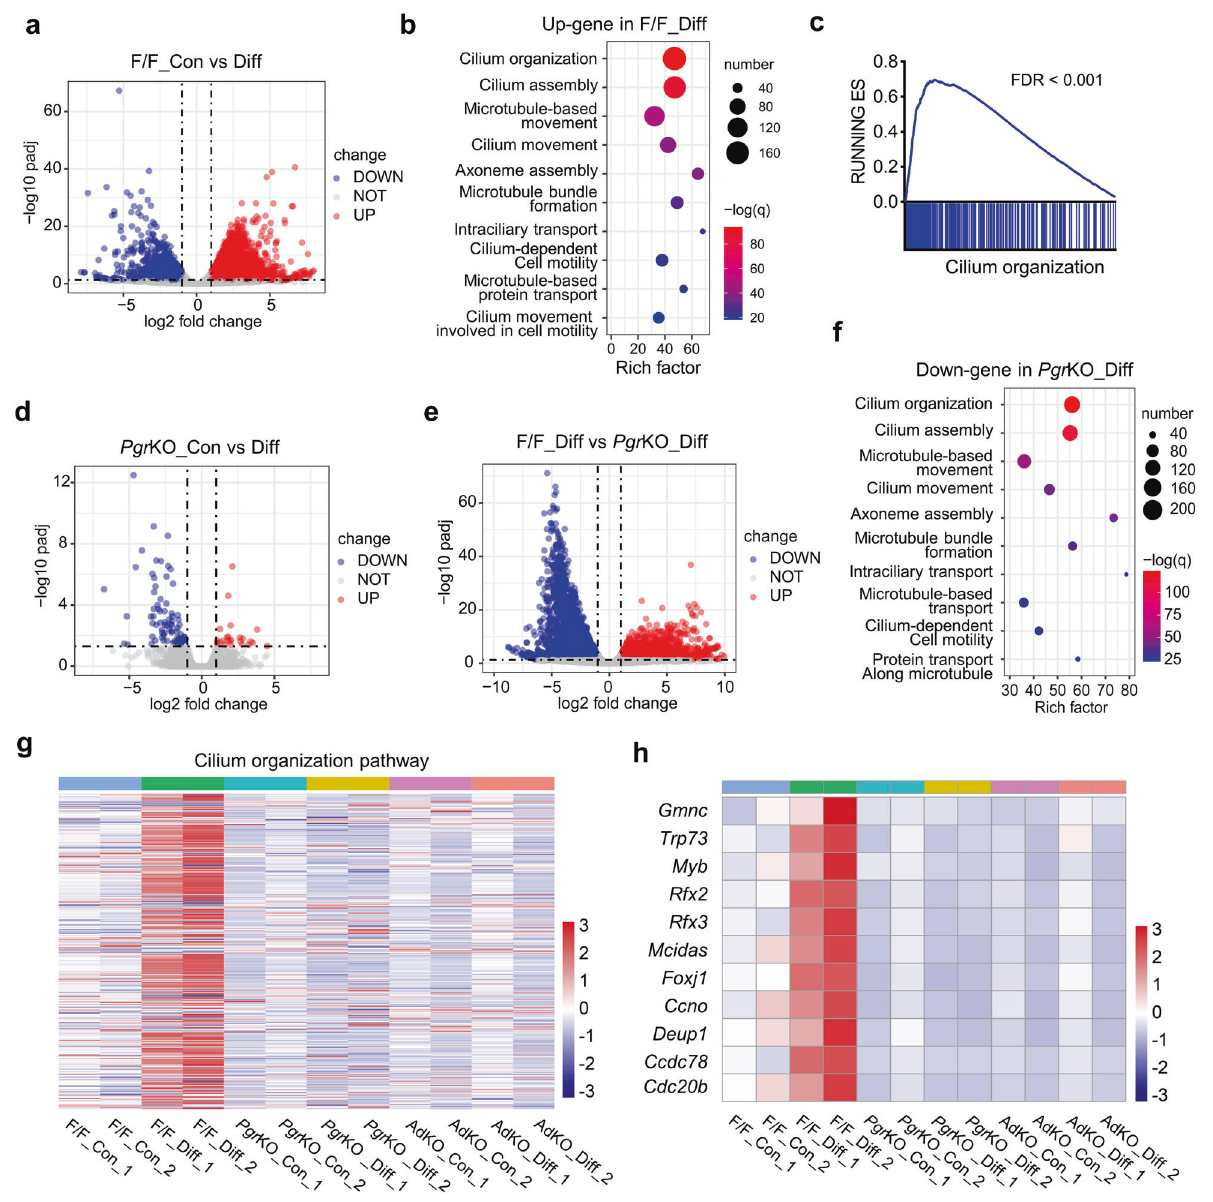
Fig. 5 CDC42 de fi cient oviductal organoids failed respond to the differentiation induction signal. a Volcano plot of differentially expressed genes in differentiated Cdc42 f/f (F/F) organoids (F/F_Diff) compared with undifferentiated F/F organoids (F/F_Con). b Go enrichment analysis of up-regulated genes in the F/F_Diff organoids compared with F/F_Con organoids. c The “ Cilium organization ” gene set was enriched in F/ F_Diff organoids according to GSEA. d Volcano plot of differentially expressed genes in differentiated Pgr KO organoids ( Pgr KO_Diff) compared with Pgr KO_Con organoids. e Volcano plot of differentially expressed genes in Pgr KO_Diff organoids compared with F/F_Diff organoids. f Go enrichment analysis of down-regulated genes in the Pgr KO_Diff organoids compared with F/F_Diff organoids. g Heatmap based on unsupervised hierarchical clustering of cilium organization pathway (GOTerm GO:0044782) and h heatmap of indicated genes expression among undifferentiated F/F organoids (F/F_Con), differentiated F/F organoids (F/F_Diff), undifferentiated Pgr KO organoids ( Pgr KO_Con), differentiated Pgr KO organoids ( Pgr KO_Diff), undifferentiated Ad-Cre-mediated Cdc42 knockout (AdKO) organoids (AdKO_Con), and differentiated AdKO organoids (AdKO_Diff). The expression levels in the heatmaps are provided as Z-scores with a range between − 3 and 3. N = 2 for each CDC42 and phospho-AKT, and reduced number of multiciliated more in the ectopic pregnancy group than that in the control cells in the fallopian tube, which could contribute to the occurrence group, and there was a negative correlation between the number of ectopic pregnancy. of CD45 positive leukocytes and the percentage of FOXJ1 positive ciliated cells in the fallopian tubes (Fig. S9a-c). We also observed a negative correlation between the number of CD45 positive leukocytes and the relative CDC42 protein levels in these samples (Fig. S9d). All the above results indicated that some women with ectopic pregnancy present the decreased expression levels of